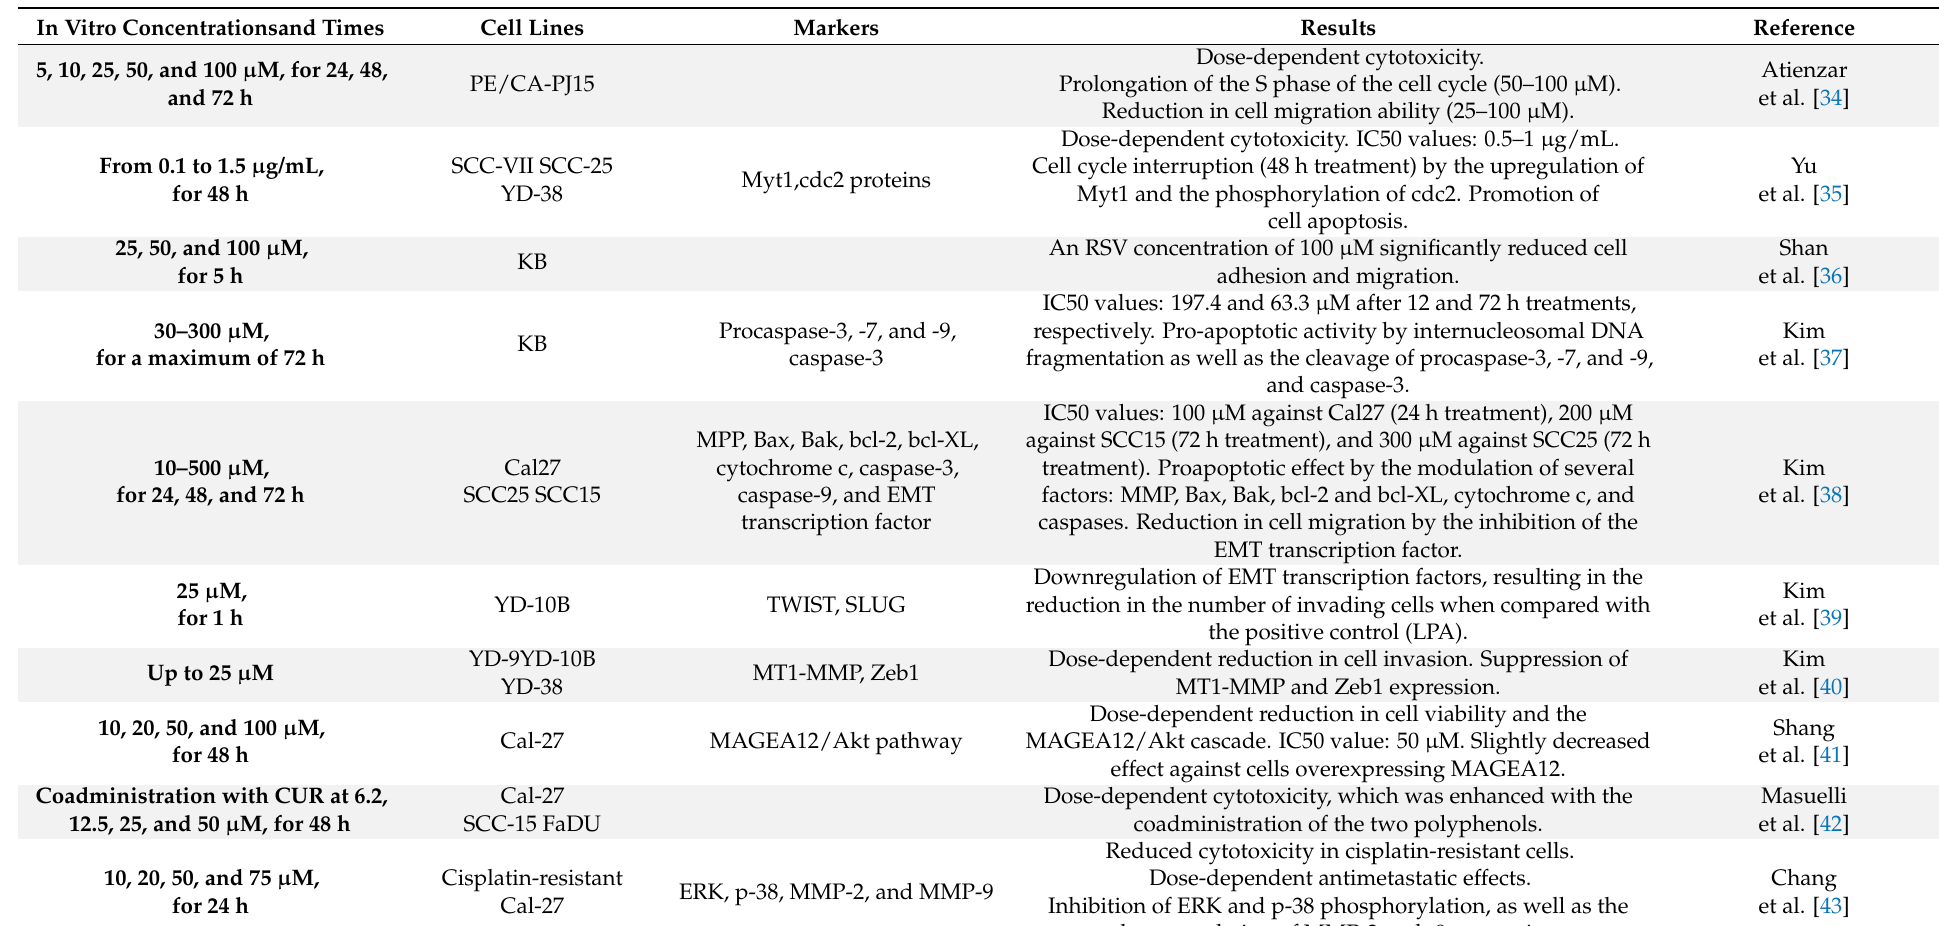
Table 1. Summary of the in vitro chemopreventive, anticancer, and antimetastatic effects of RSV and PD against OSCC-related cancer cell lines: tested concentrations, times, employed cells, markers, and general